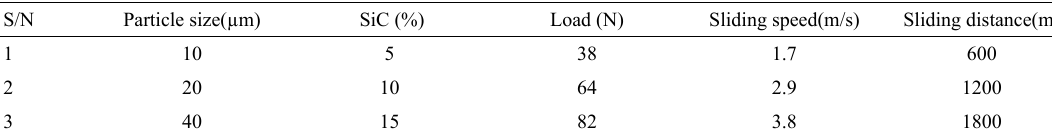
Table 9. Confirmation test